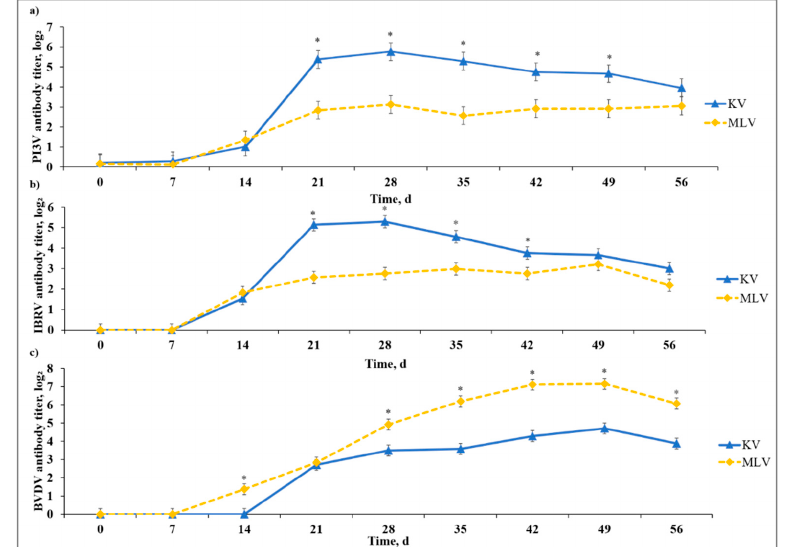
Figure 1. Effect of killed virus (KV; Triangle 5; Boehringer Ingelheim Animal Health, Inc. (BIAH)) and